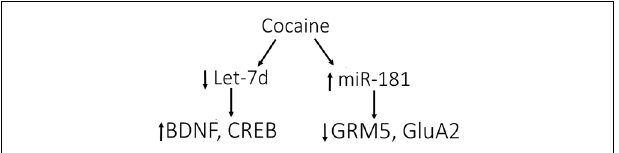
FIGURE 2 | Model for cocaine-induced microRNA-mRNA interactions. Cocaine causes the down-regulation of let-7d, resulting in induction of its target genes, BDNF and cAMP-responsive element-binding protein (CREB). In contrast, miR-181a is up-regulated by cocaine, causing down-regulation of its targets, GRM5 (glutamate metabotropic receptor 5) and AMPA receptor subunit 2 (GluA2).These data support the involvement of let-7d and miR-181a in regulating the differential expression of various genes in response to cocaine, which may impact molecular adaptations leading to addiction. Figure and legend were modified from the original in Jonkman and Kenny